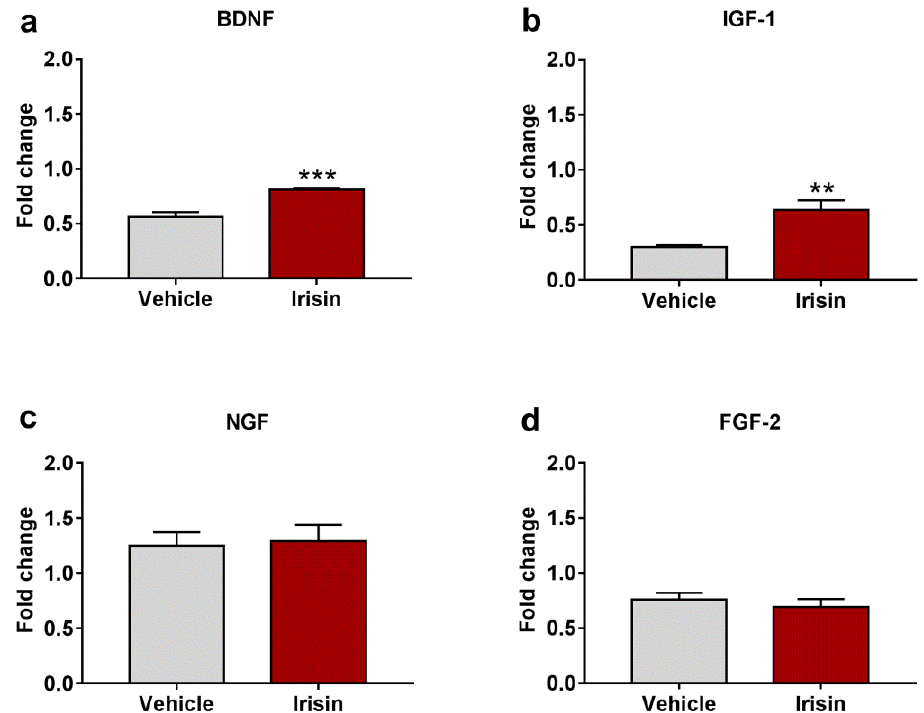
Figure 5. Irisin effect on neurotrophic factor expression. Gene expression of Bdnf ( a ), Igf-1 ( b ), Ngf ( c ), and Fgf-2 ( d ). Histograms represent mean expression ± SEM. Unpaired two-tailed Student’s t- test was used for statistical analysis. ** p < 0.01; *** p < 0.001.